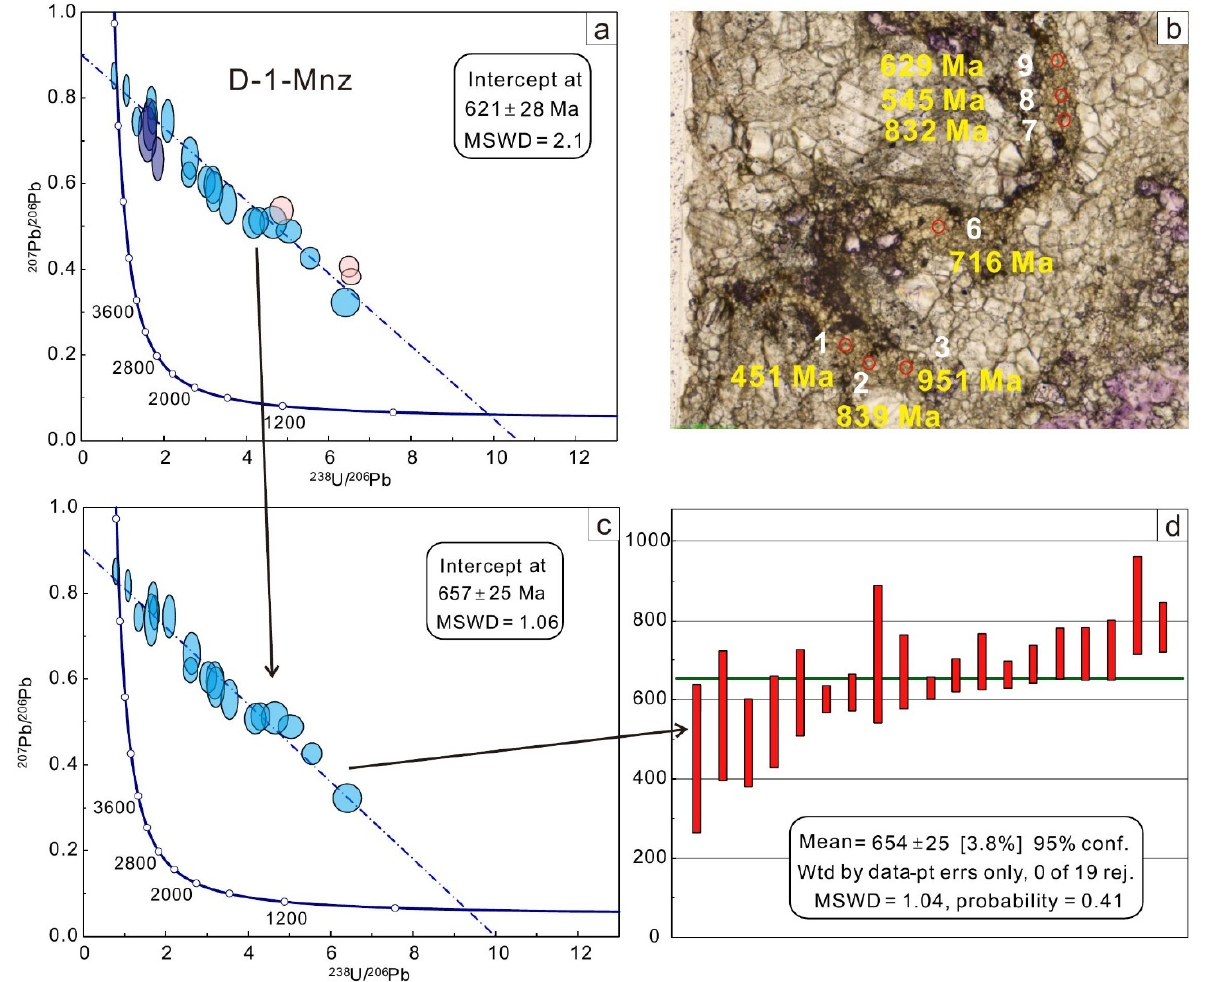
Figure 8. Monazite Concordia diagram of sample D-1 from the Bayan Obo deposit. ( a ) The Intercept age of all dates. ( b ) The detail testing locations and age distribution characteristics in monazite. ( c ) The Intercept age of the blue group. ( d ) The mean age dates of the blue group. The monazite in sample Fe-1 presents coarse-grained crystals up to ~600 µm in size. The corrected intercept of the 207 Pb age was divided into three groups. The dominant age group yielded a weighted 206 Pb mean age of 763 ± 16 Ma (MSWD = 1.3). The maximum and minimum single-point ages were 1393 ± 142 Ma and 429 ± 24 Ma, respectively. The ages of single monazites also vary widely (Table 2 and Figure